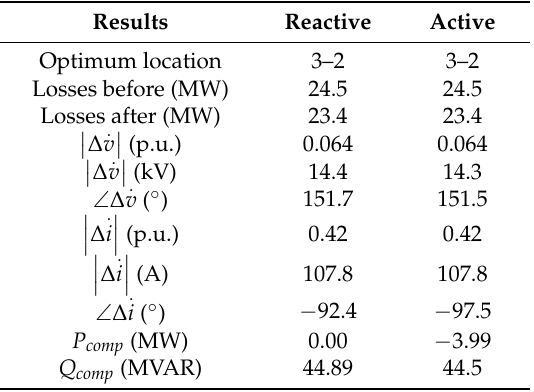
Table 5. Reactive combined FACTS